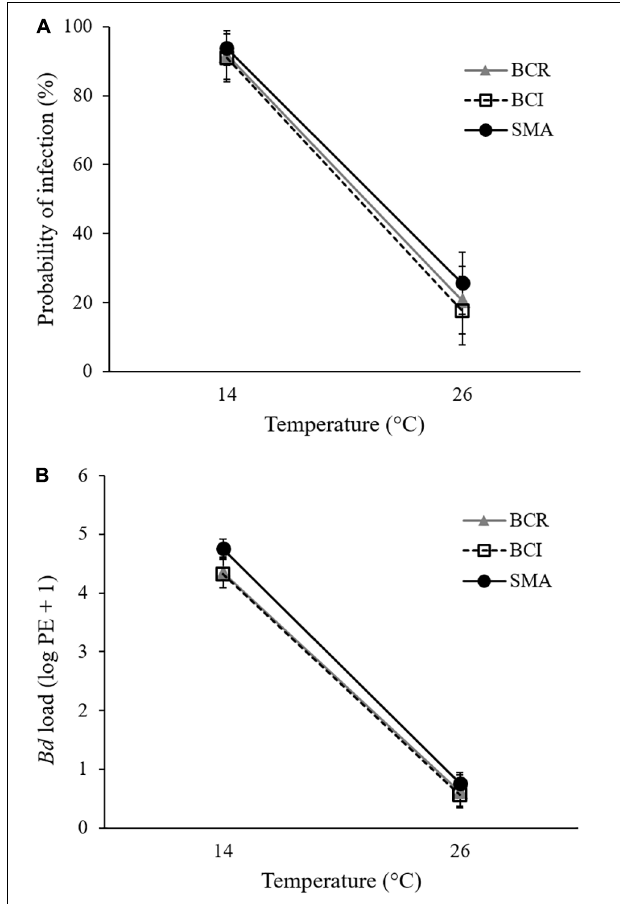
FIGURE 1 | Mean ( ± SE) of (A) probability of infection and (B) Bd load, measured as log 10 of plasmid equivalents (PEs) for Bd -exposed frogs at two treatment temperatures and three bacterial manipulations (BCR, bacterial community reduced; BCI, bacterial community intact; and SMA, S. maltophilia added) over the 9 weeks of the experiment.